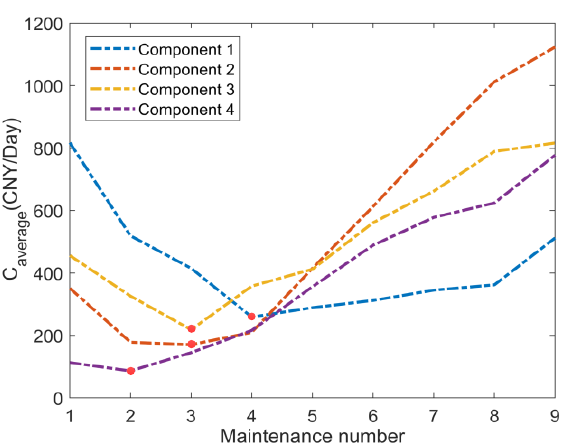
Figure 10. Schematic diagram of warranty cost per unit time changes of each component.